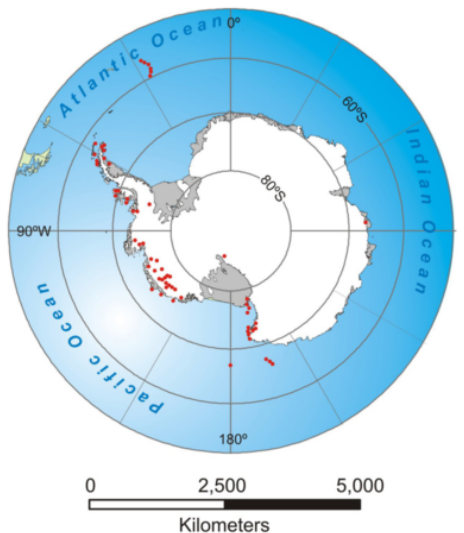
Figure 1. Main known volcanoes in Antarctica (red dots; Antarc- ticGlaciers.org from 2014; see also LeMasurier and Thomson [1990]). Only a small number of volcanoes are